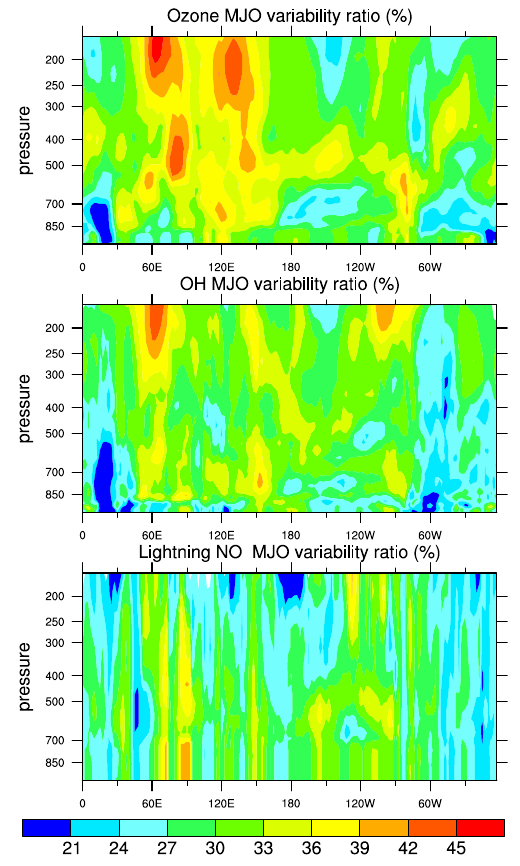
Figure 9. MJO variability ratio (given in percentage) for ozone, OH and lightning Fig. 9. MJO variability ratio (given in percentage) for ozone, OH and lightning NO.